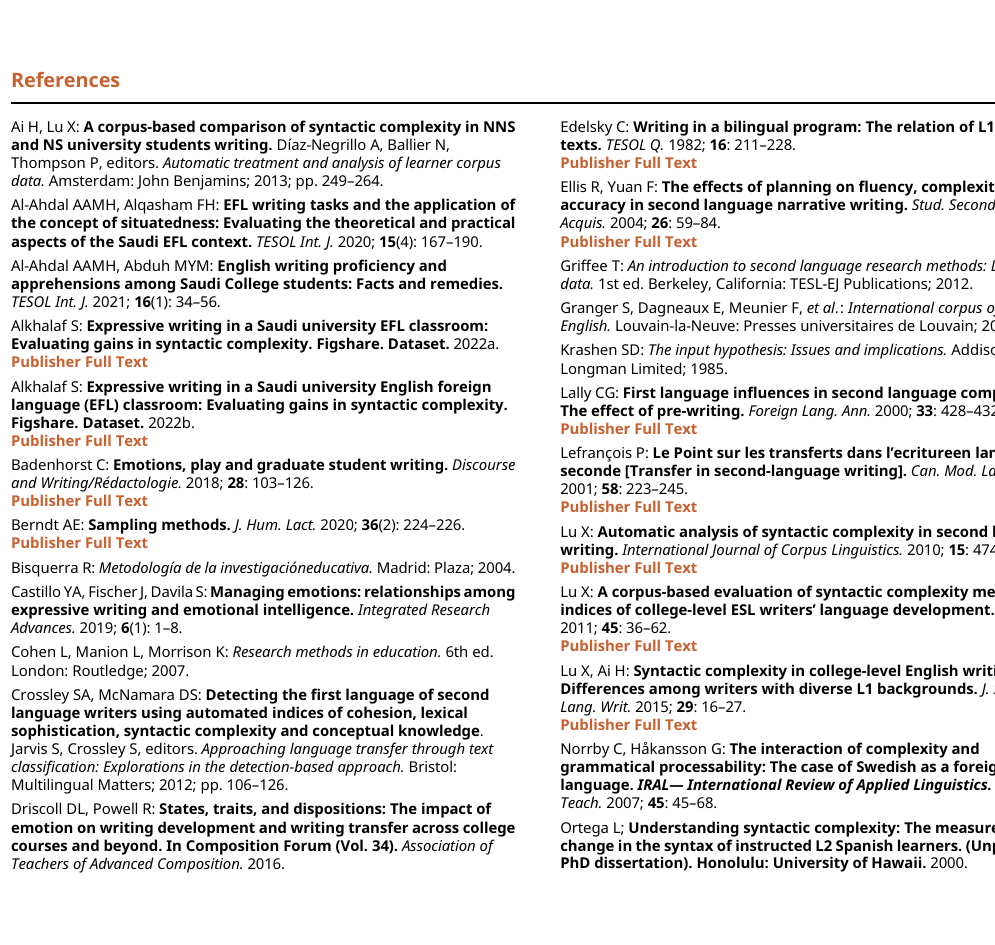
Figshare. Expressive Writing in a Saudi university EFL classroom: Evaluating gains in syntactic complexity. https://doi.